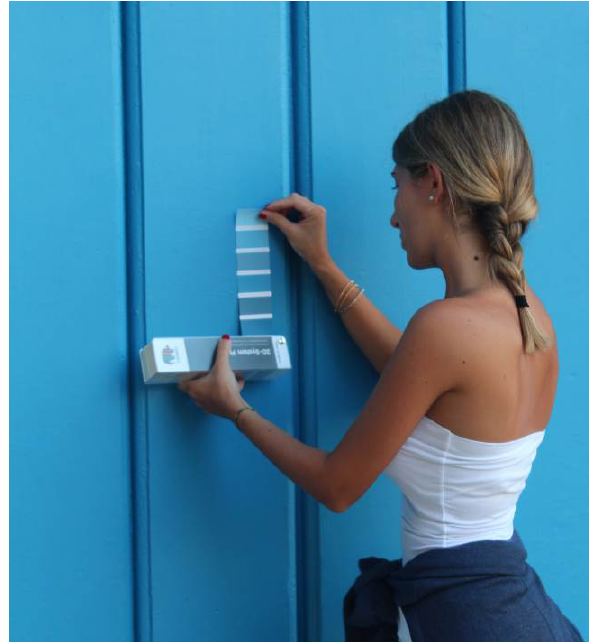
Figure 6. Colorimetric survey